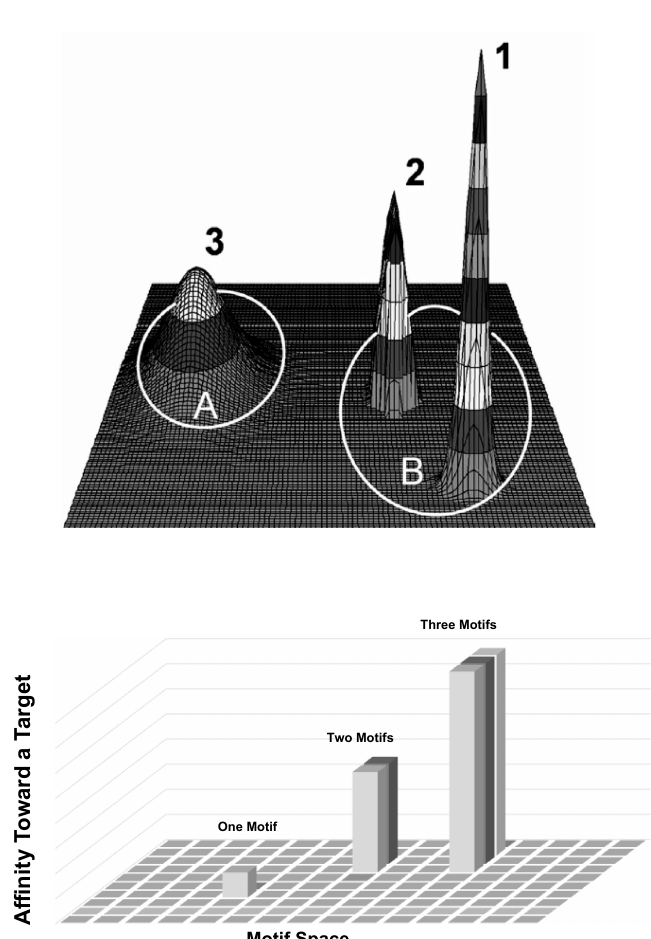
Figure 5. Three-dimensional representation of peptide populations in a theoretical sequence space. ( A ) Adapted from [26]. A highly simplified two-dimensional table of all possible combinations of amino acids for a given number of randomized positions can be represented as a grid with each position in the grid standing for a unique combination of amino acids. Phage libraries would be seen as a collection of random points in the sequence space and be expected to form overlapping domains within such a grid as depicted in labeled circles A and B. An additional dimension is superimposed onto the grid when libraries are considered in their context of affinity towards a target. When a structurally related peptide clusters on the basis of their target affinity, an ‘affinity cone’ is generated (peaks 1, 2, and 3) with affinity towards the target increasing from the base of the cone to the peak of the cone until a ‘lead peptide’ with highest affinity is identified. ( B ) Following a previously suggested model [8], a highly simplified two-dimensional table of all possible combinations of EBUs for a given number of randomized positions can be represented as a grid with each position of a grid standing for a unique combination of EBUs. For simplicity, we assume that points that are close together represent similar functioning EBUs. Here, we illustrate the possible sequences for a hypothetical library with two non-overlapping sets of randomized EBUs along the axes of the planes for ~60,000 (20 × 20 × 20 × 7) of possible tripeptides. An additional dimension is superimposed onto the grid when phage libraries are considered for their affinity towards a given complex target. As the number of EBUs combine to form functional SLiMs their affinity is enriched as demonstrated by the accumulation of taller peaks with each added EBU into the total peptide structure.